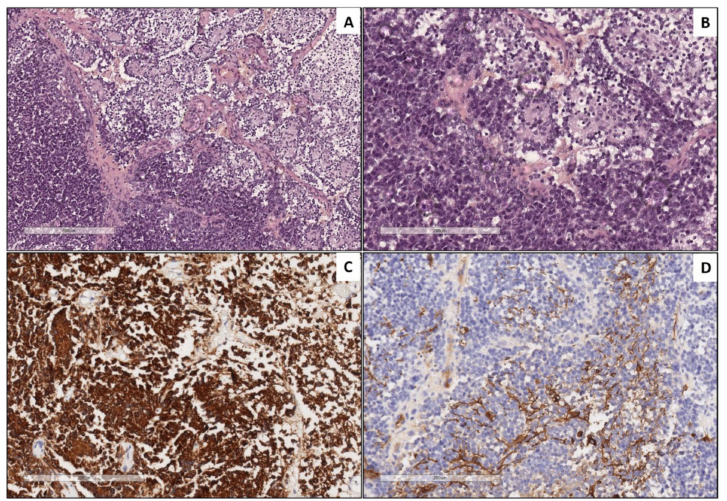
Figure 2. Pineal anlage tumor (relapse specimen). Neuroepithelial component characterized by solid areas of small round blue cells with hyperchromatic nuclei and high N:C ratio (left side) associated to Homer-Wright rosettes (right side) (( A ) and ( B ), respectively). Synaptophysin staining neuroepithelial cells ( C ). Scattered neoplastic glial cells positive for glial fibrillary acidic protein ( D